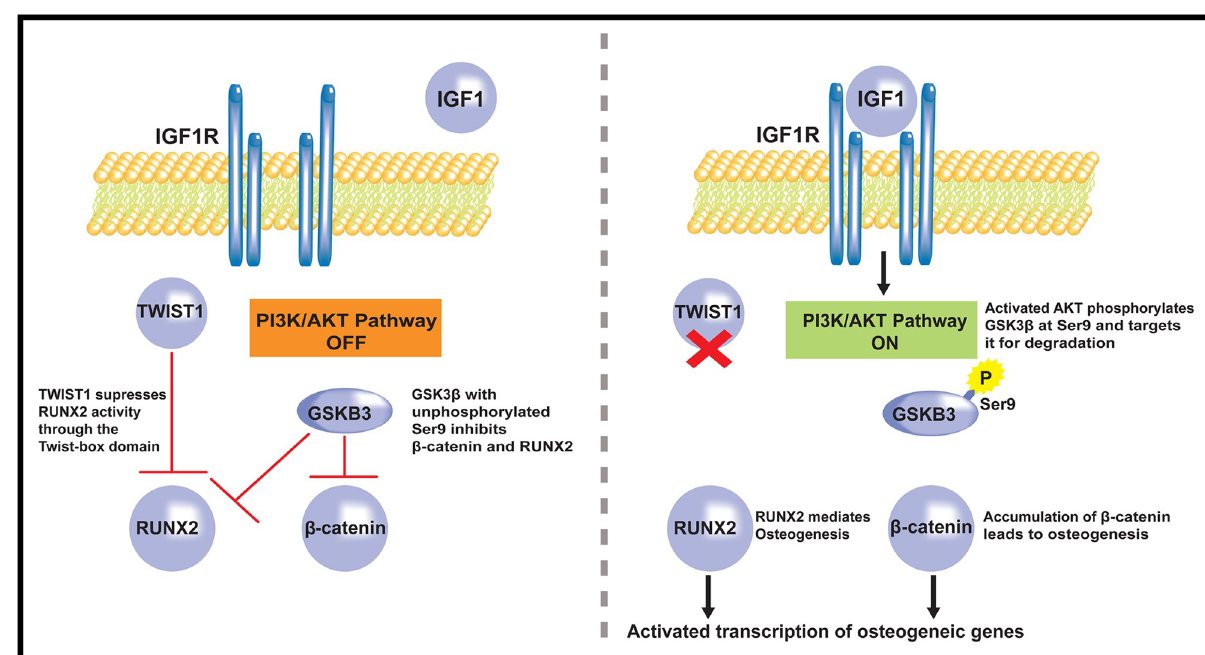
Fig 4. Schematic representation of intersection of pathways of interest. (Left Panel) In the absence of IGF1/IGF1R binding, the Akt pathway is inactive and GSK3 β Ser9 is unphosphorylated resulting in inhibition of RUNX2 (through phosphorylation of S369, S373, S377) and β -catenin. In parallel, TWIST1 suppresses RUNX2 function via direct interaction of RUNX2 with the twist-box domain of TWIST1. (Right Panel) In our experimental system we tested the hypothesis that dysregulation of both the TWIST1/RUNX2 and IGF1/Akt pathways would result in an increased incidence of craniosynostosis. This schematic demonstrates our hypothesis that the combination of a twist-box mutation of Twist1 and activation of the IGF1/AKT pathway would result in activation of osteogenic transcripts and manifest as craniosynostosis. The pathways shown are derived from previously described data [19, 41, 43,